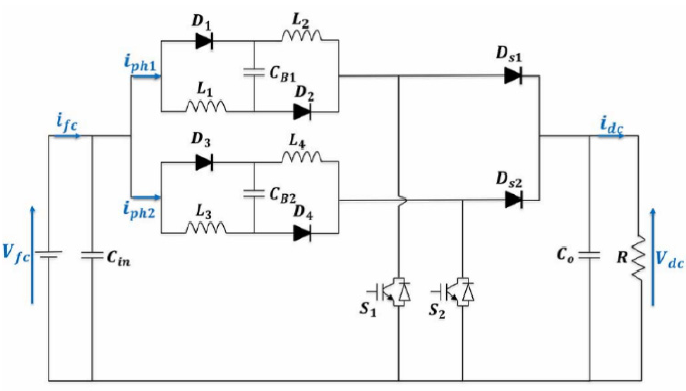
Figure 1. Structure of the proposed interleaved high gain DC-DC boost converter.